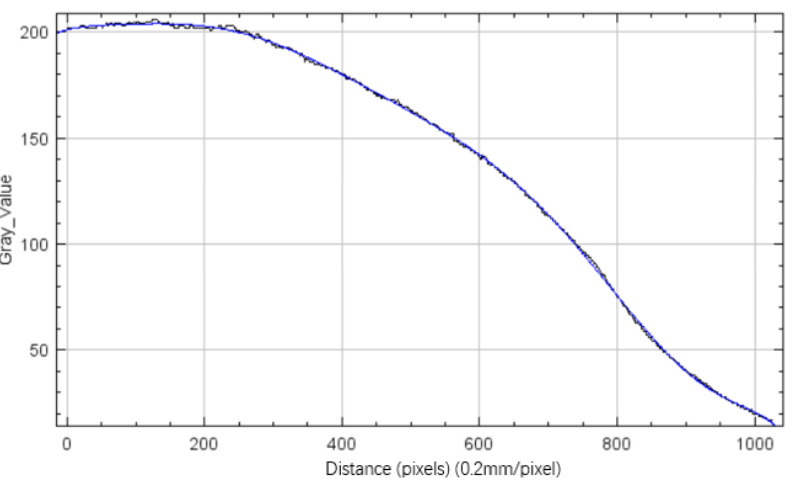
Figure 15. Gray value from low to high and typical materials.